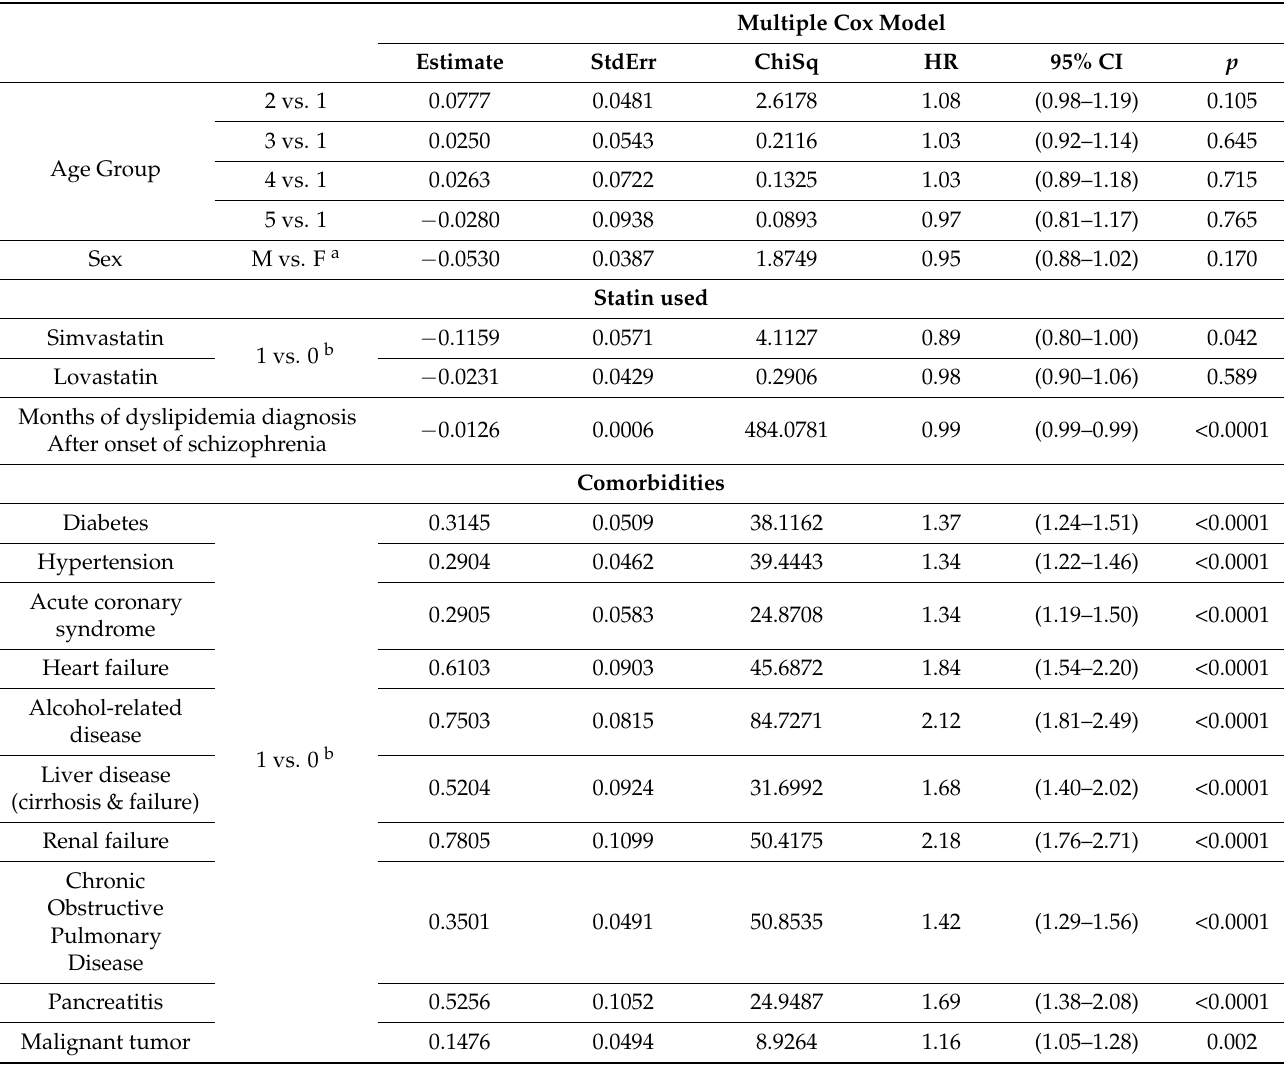
Table 3. Multivariate-adjusted cox proportional hazard regression models for overall